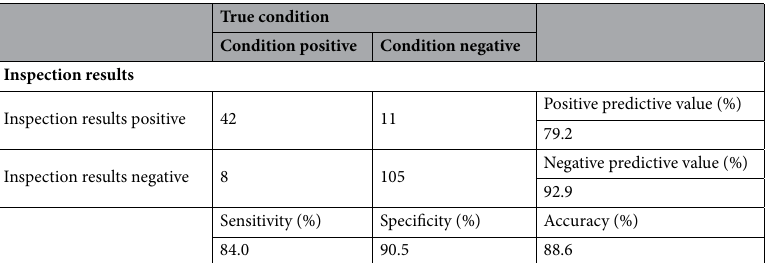
Table 5. The performance of the constructed model applying to the external validation set. BCP breast cancer patient, HC healthy control.